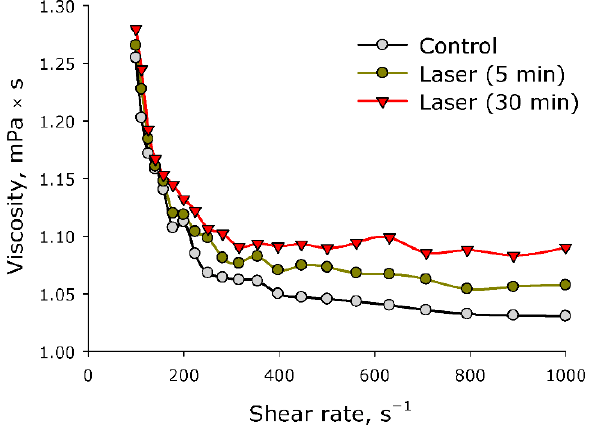
632.9nm Figure 7. Effect of laser irradiation time on the refractive index of aqueous solution of BSA at wavelengths of 435.8 nm, 589.3 nm, 632.8 nm. Data obtained using precision refractometry ( n = 3,